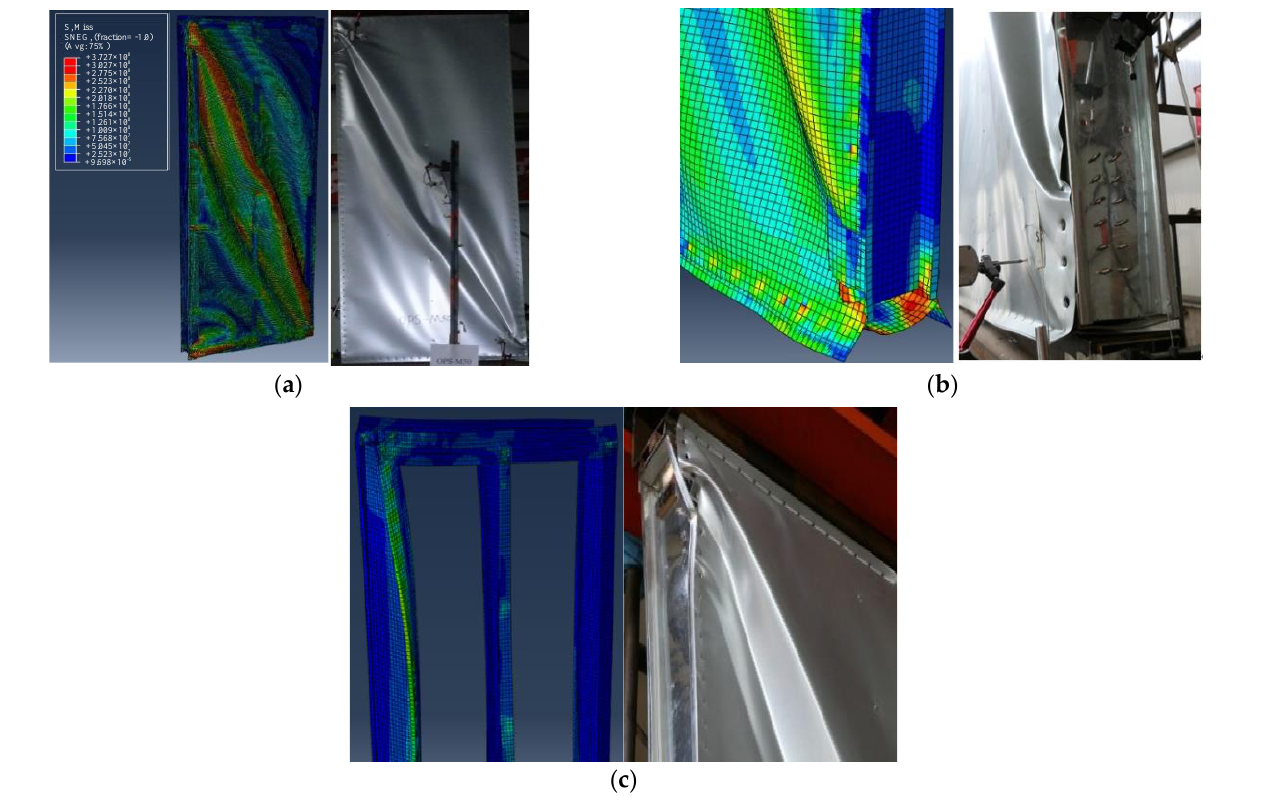
Figure 18. Comparison of failure modes between the FEA and the test results for specimen W − 1: ( a ) shear buckling of steel sheathing and the pull-out of the rivet head from sheathing, ( b ) distortional buckling of the track, ( c ) bend-buckling of end stud.